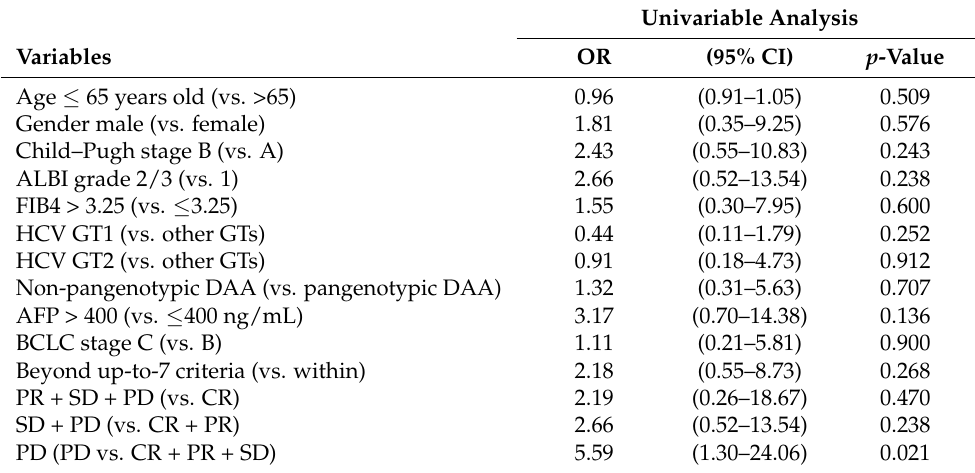
Table 2. The strength of association between non-SVR and variables.